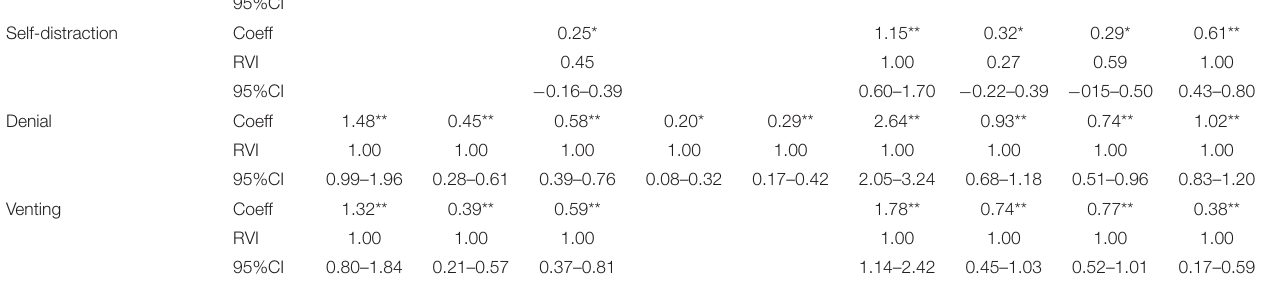
GHQ-28 IES-R Predictor Total Somatic Anxiety and Social Severe Total Intrusion symptoms insomnia dysfunction depression